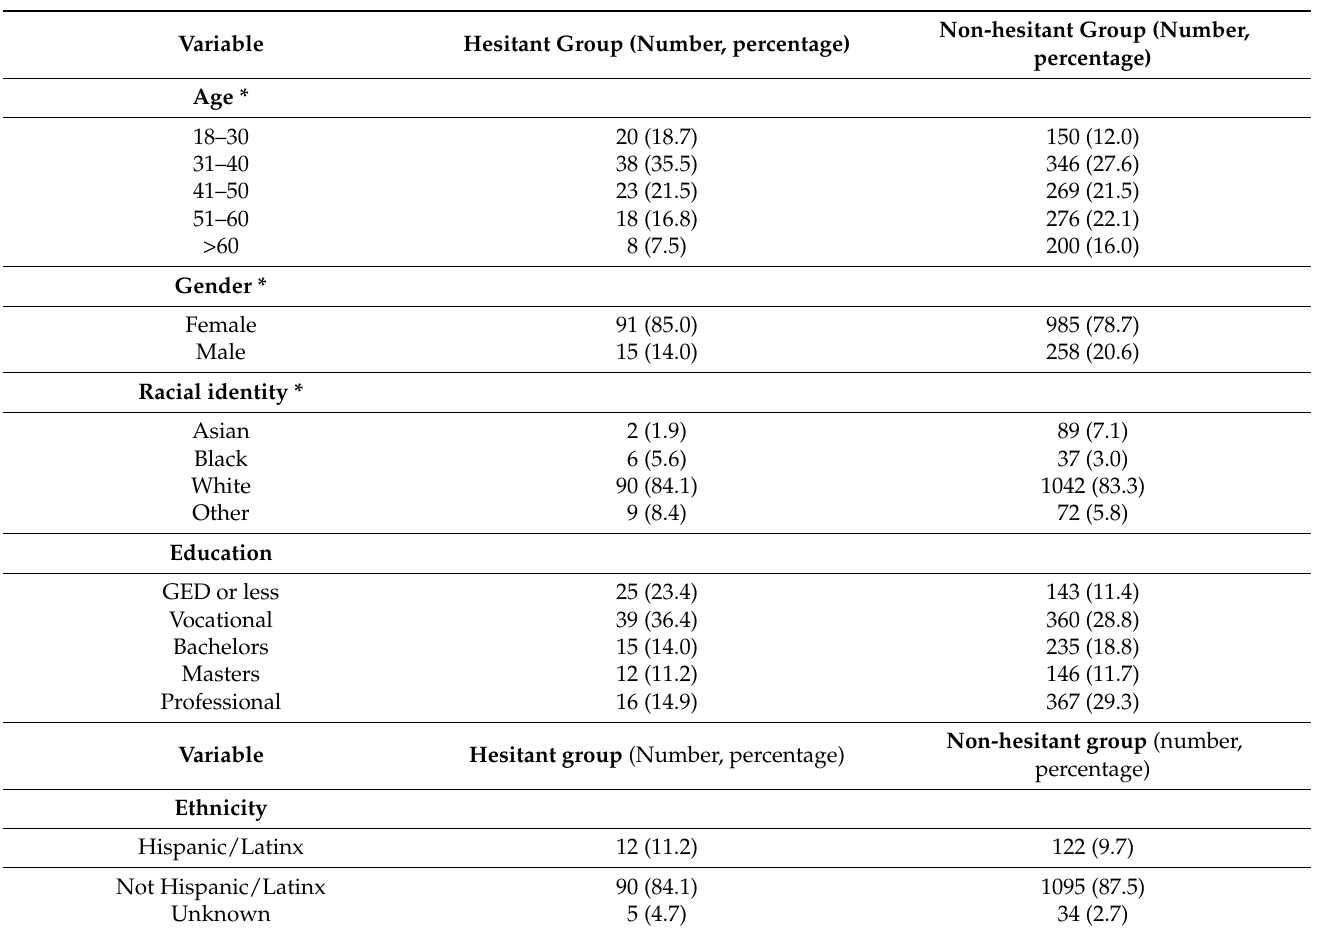
Table 2. Comparison of hesitant and non-hesitant